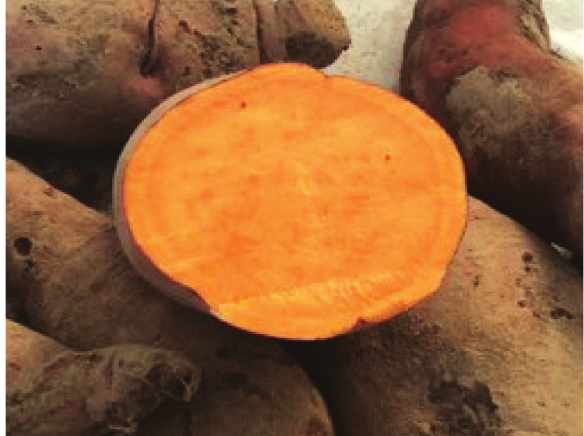
Figure 1. Ipomoea batatas